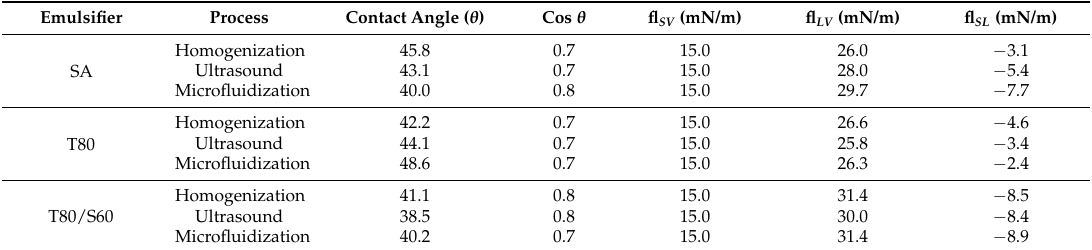
Table 2. Contact angle and surface tensions of BW–starch nanoemulsions on the tomato surface. Emulsifier Process Contact Angle ( θ ) Cos θ